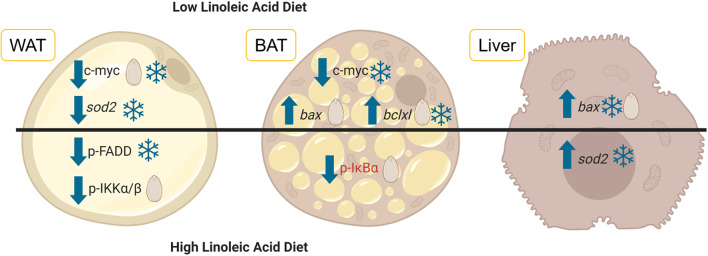
Diets differing in the levels of linoleic acid (LA) and alpha-linolenic acid (ALA) were fed to garden dormice before they entered hibernation naturally. White adipose tissue (WAT, depicted on the left), brown adipose tissue (BAT, shown in the middle) and liver tissue (depicted on the right) were extracted from dormice before and during torpor and the levels of key proteins and genes involved in the regulation of the response to oxidative stress and inflammation were assessed using multiplex antibody-based assays or RT-qPCR. The results of this study are summarized here where arrows indicate whether relative protein levels (normal font) or mRNA (italic font) increased or decreased relative to the euthermic control (snowflake) or relative to the intermediate LA diet (seed). Changes that occurred in torpid animals use blue lettering and the one change that occurred in euthermic animals uses red lettering. The image was created using BioRender. Abbreviations are as follows: p-FADD, phosphorylated Fas Associated Via Death Domain; p-IKKα/β, phosphorylated Inhibitor Of Nuclear Factor Kappa B Kinase subunits alpha and beta; p-IκBα, phosphorylated NF-Kappa-B Inhibitor Alpha; bax, BCL2 Associated X Protein; bclxl, BCL2 Like 1; sod2, Superoxide dismutase 2.